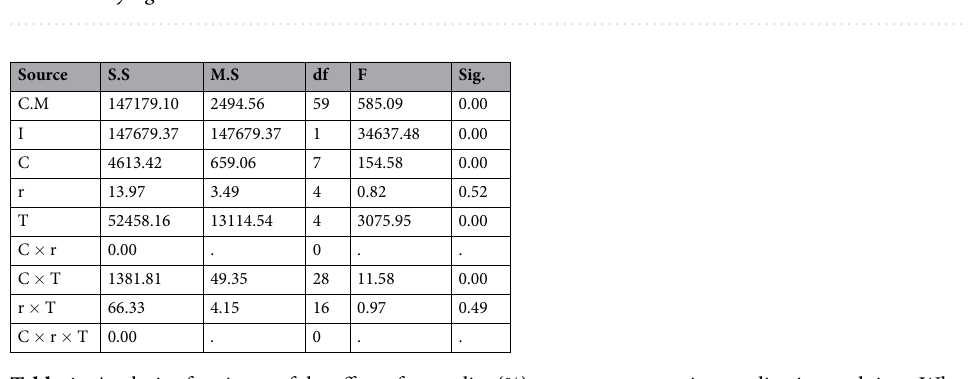
Table 4. Analysis of variance of the effect of mortality (%) versus concentration, replication and time. Whereas: S.S (Sum of square); M.S (Mean square); df (Degree of freedom); C.M (Corrected model); I (Intercept); C (Concentration); r (Replication); T (Time); C × r (Concentration × replication); C × T (Concentration